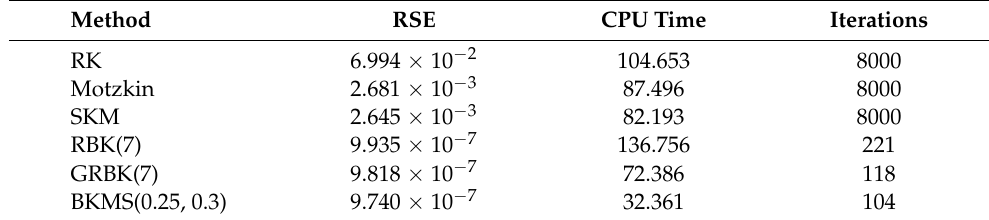
Table 6. Numerical results for restoring the “ phantom ”